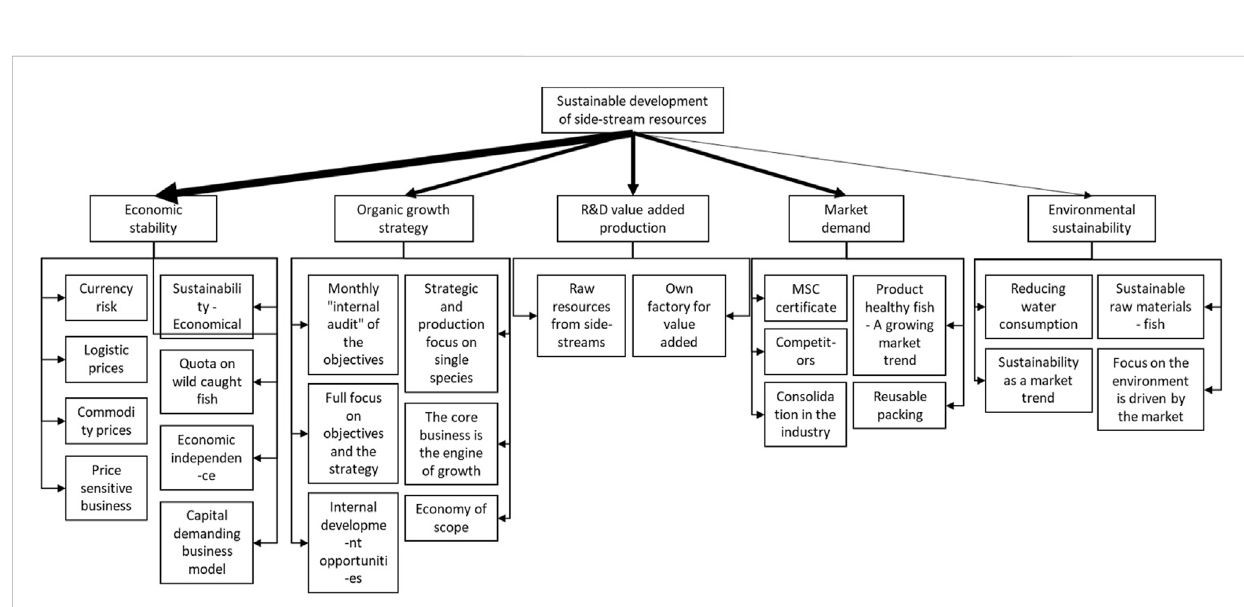
FIGURE 3 Exampleofattributesubstitution — decisionmakers ’ viewofsustainabledevelopmentofside-streamresourcesinCompanyA.Foralargerversionof this fi gure, see Supplementary Material